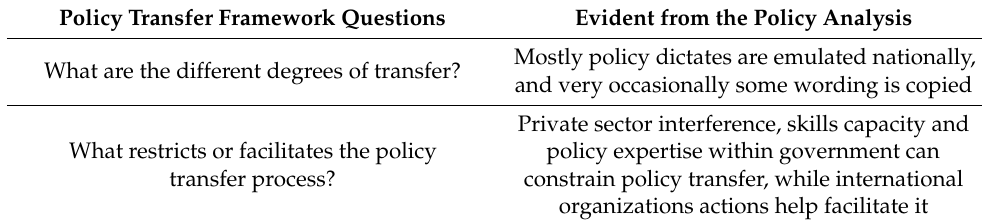
Table 1. Cont. Policy Transfer Framework